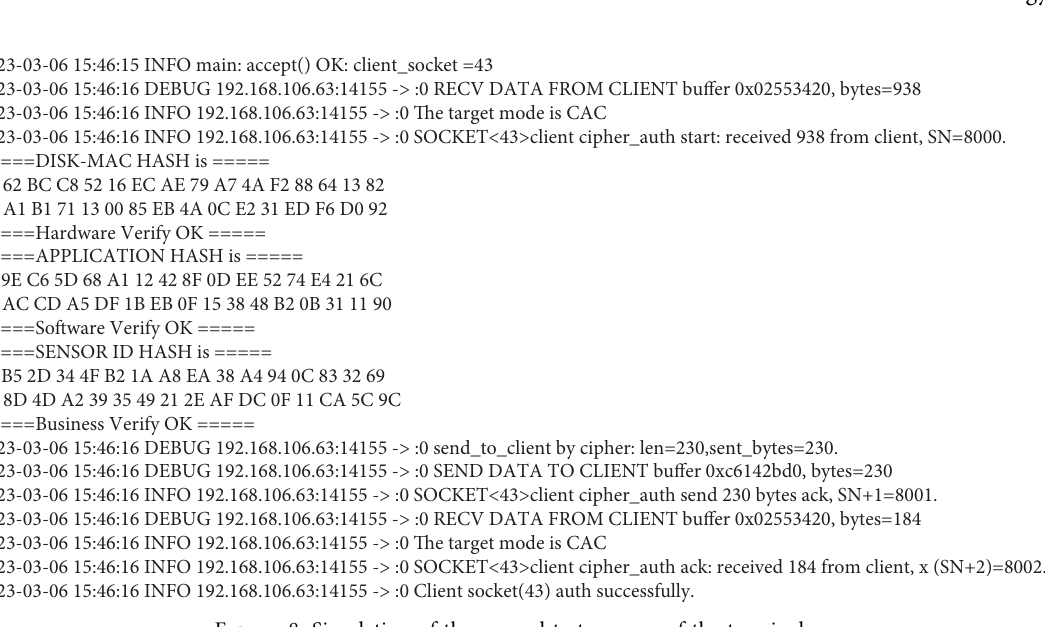
Figure 8: Simulation of the normal test process of the